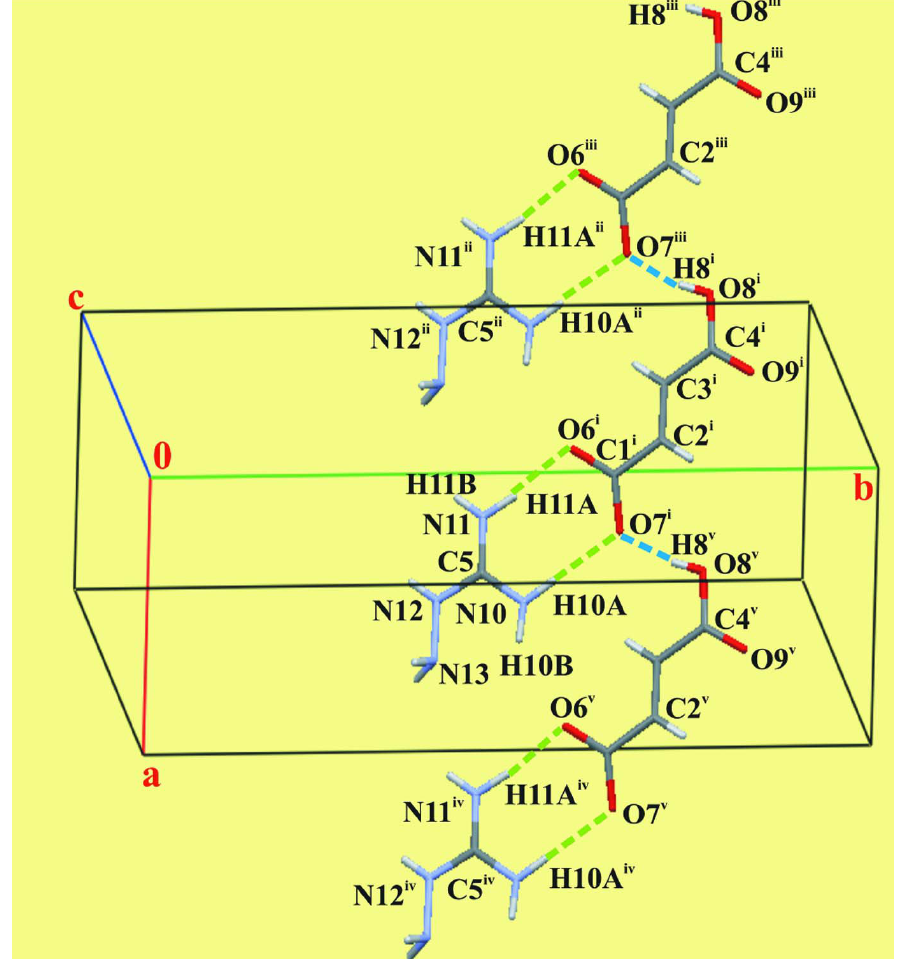
Figure 2 N—H···O and O—H···O hydrogen bonds (dotted lines) in the title compound. [Symmetry codes: (i) x-1, -y+3/2, z-1/2; (ii)x-1, y,